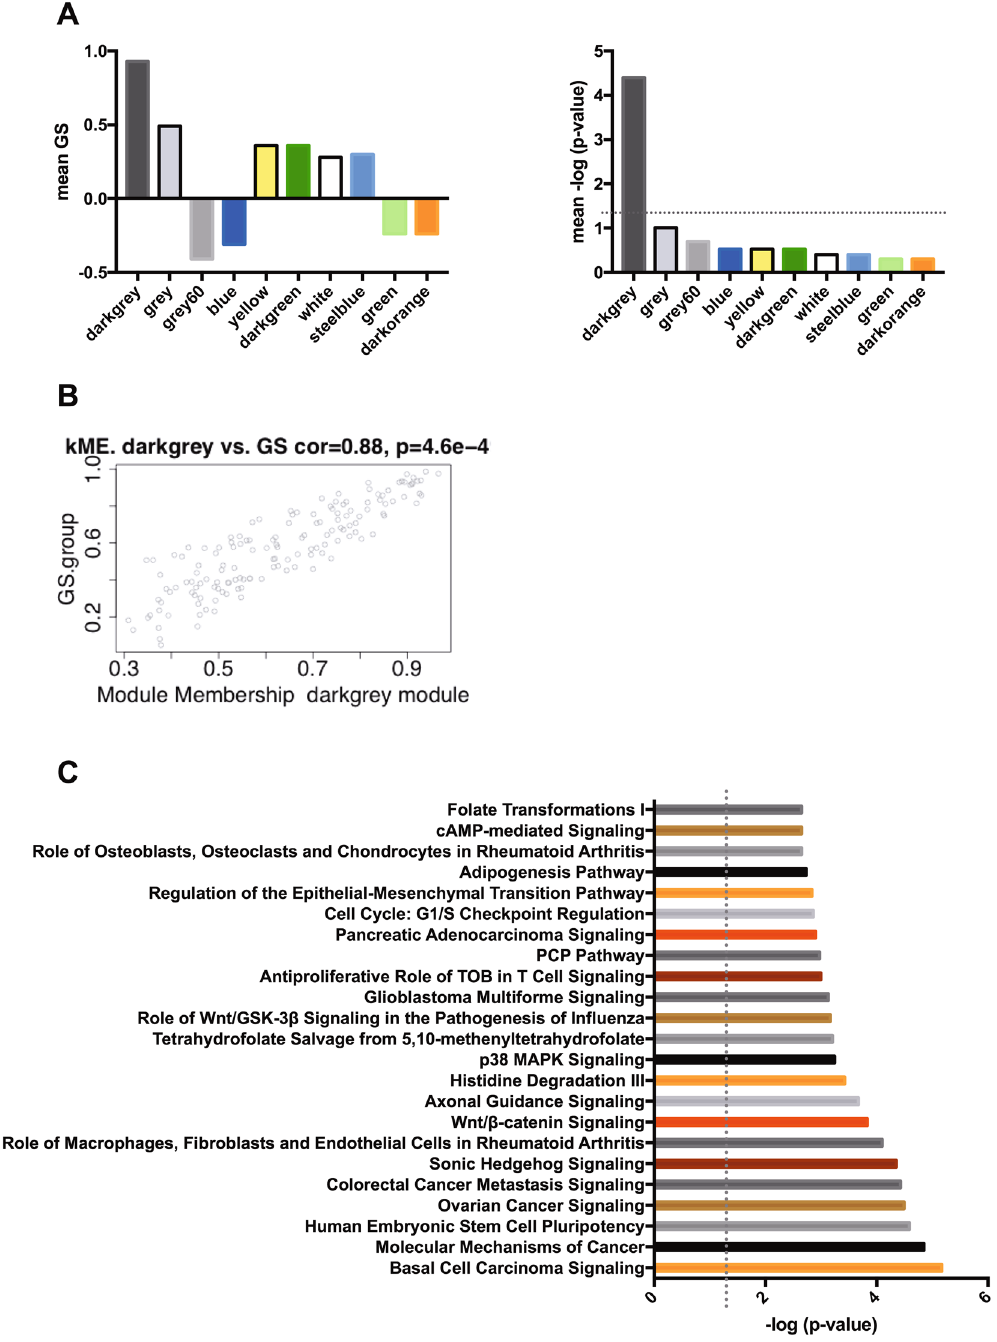
Figure 5. Weighted correlation network analysis (WGCNA) of hippocampal expression data in CD and FD F1 mice. ( A ) Graphs show module-trait relationships and corresponding p-values (presented as –log of the p-value) of the top ten modules detected via WGCNA (module names are provided on the x-axes). The p-value threshold of –log (0.05) is indicated by a dotted line. ( B ) Scatterplot of gene significance (GS.group) versus module membership (kME) for the darkgrey module. We observed a strong correlation between GS values for group (maternal diet) and module membership. ( C ) The graph shows the top enriched canonical pathways among genes with membership in the darkgrey